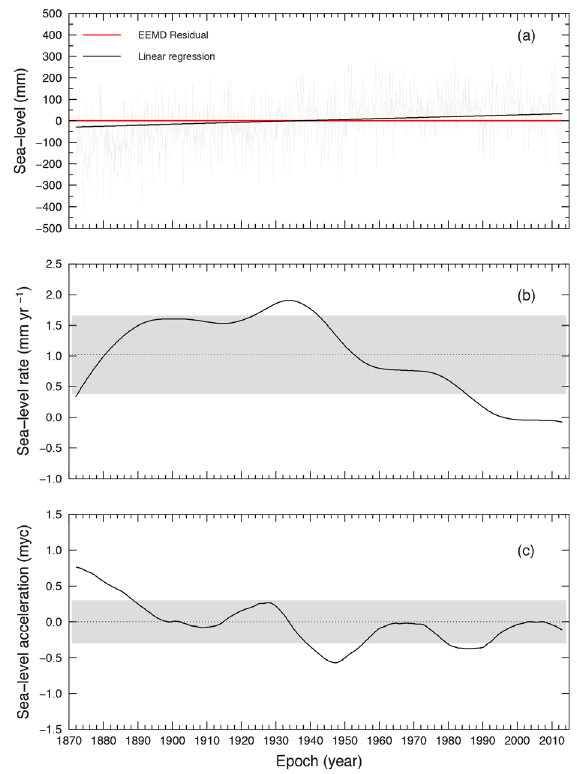
Figure 6. (a) EEMD residual (red) and its linear regression (black) for the AS (gray). (b) First difference (in mm/yr) and (c) second dif- ferences on the residual (in myc, where 1 myc=mm/yr/century). Average values of first and second differences (dotted lines) and their uncertainty